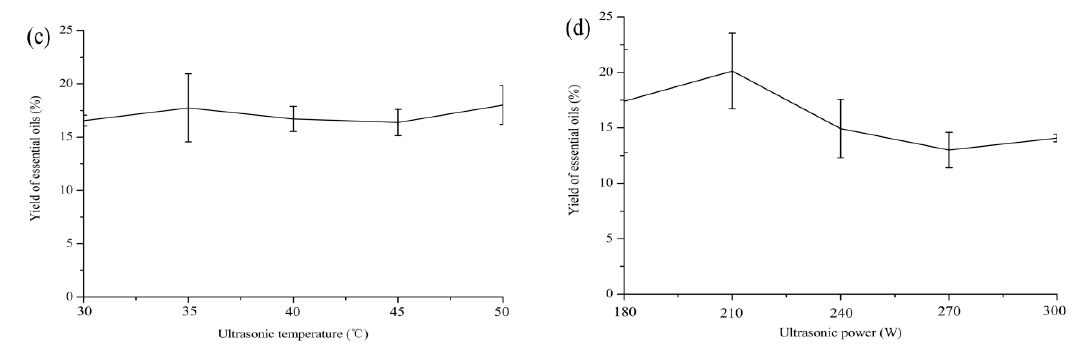
Figure 1. Effect of different parameters on the extraction yield of essential oils from S. sphenanthera : ( a ) ratio of material to solvent; ( b ) ultrasonic time; ( c ) ultrasonic temperature; ( d ) ultrasonic power.